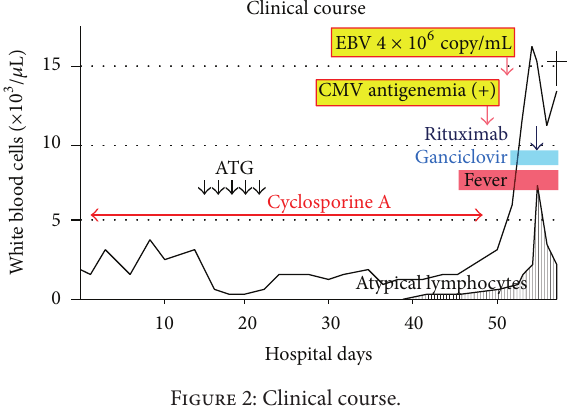
Figure 2: Clinical course.